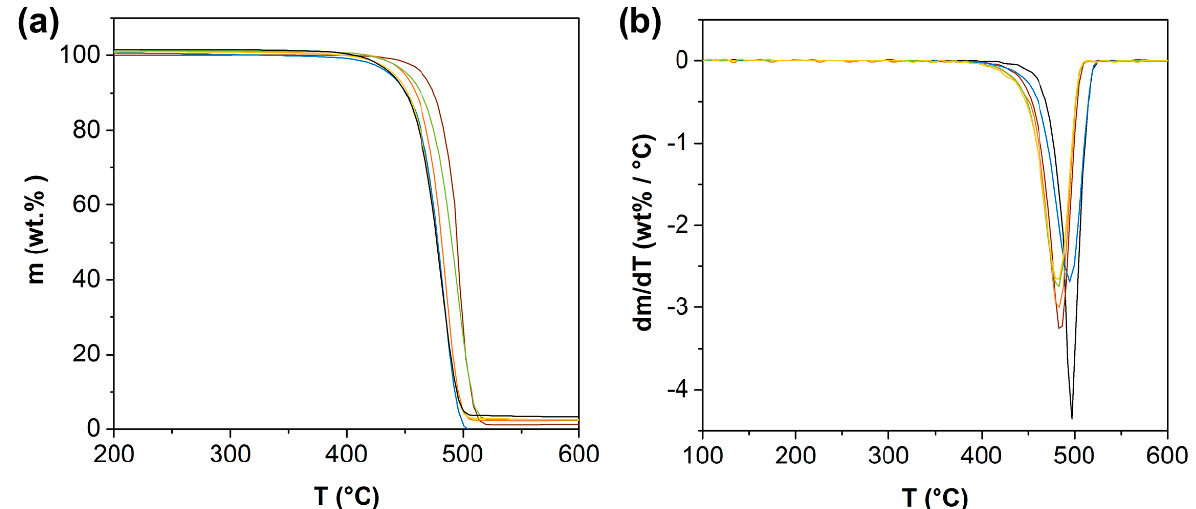
Figure 6. Effect of the recycling and the addition of Cu-NPs and Cu-NCs on the thermogravimetry of ( ) HDPE, ( ) HDPE 0.5 wt.% Cu-NPs, ( ) HDPE 0.7 wt.% Cu-NCs, ( ) rHDPE, ( ) rHDPE 0.5 wt.% Cu-NPs, and ( ) rHDPE 0.7 wt.% Cu-NCs. ( a ) TGA analysis and ( b ) max- imum thermal degradation rate.